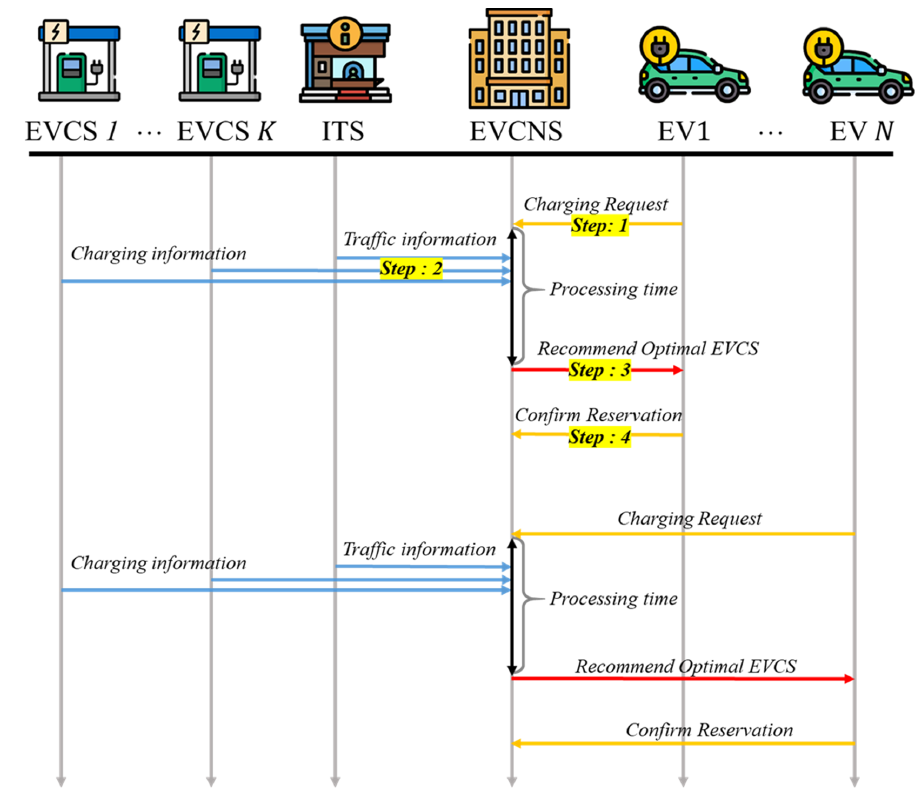
Figure 2. Information flow for system operation of the proposed EVCNS.